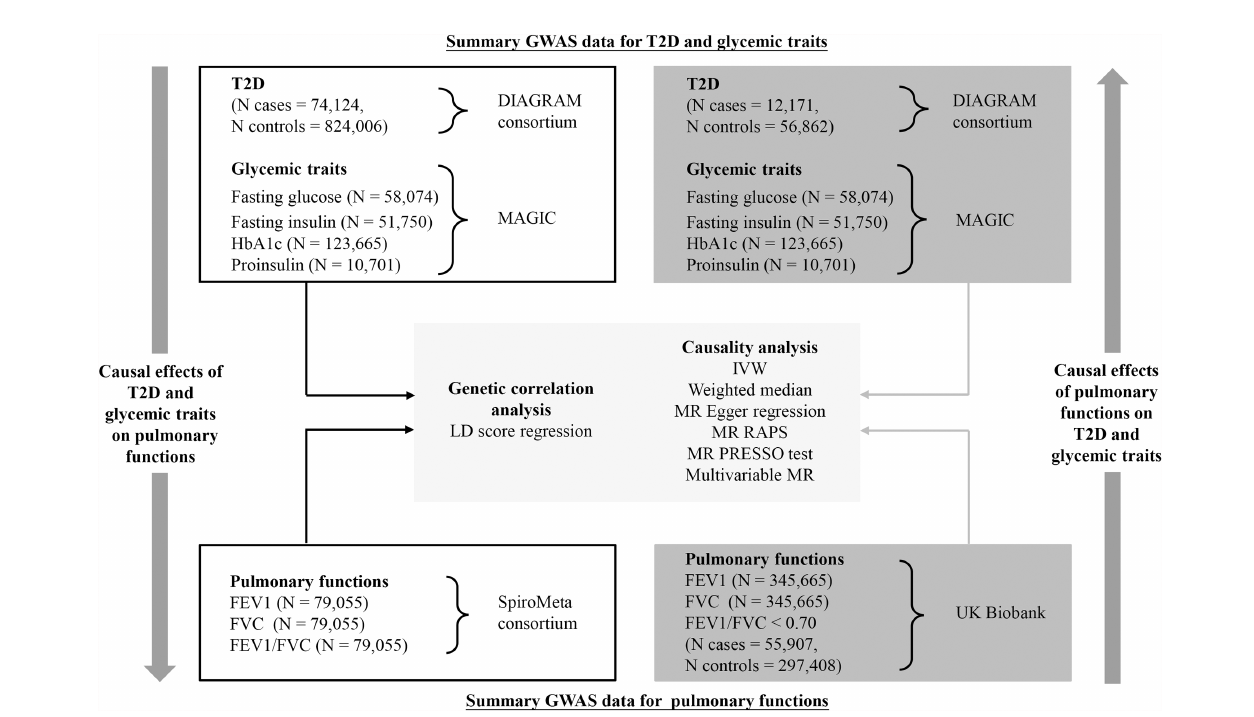
FIGURE 1 | Schematic overview of the study design. FEV1, forced expiratory volume in 1 s; FVC, forced vital capacity; GWAS, genome-wide association study; HbA1c, hemoglobin A1c; MR, Mendelian randomization; T2D, type 2